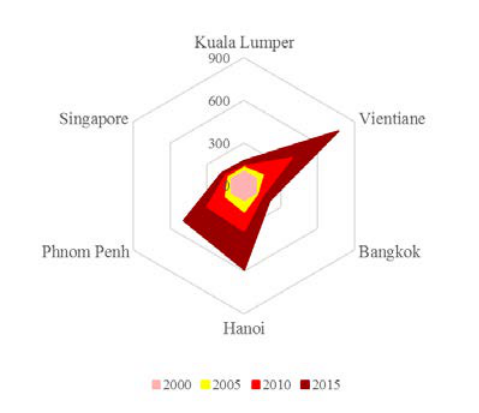
Figure 5. Percentage of area expansion